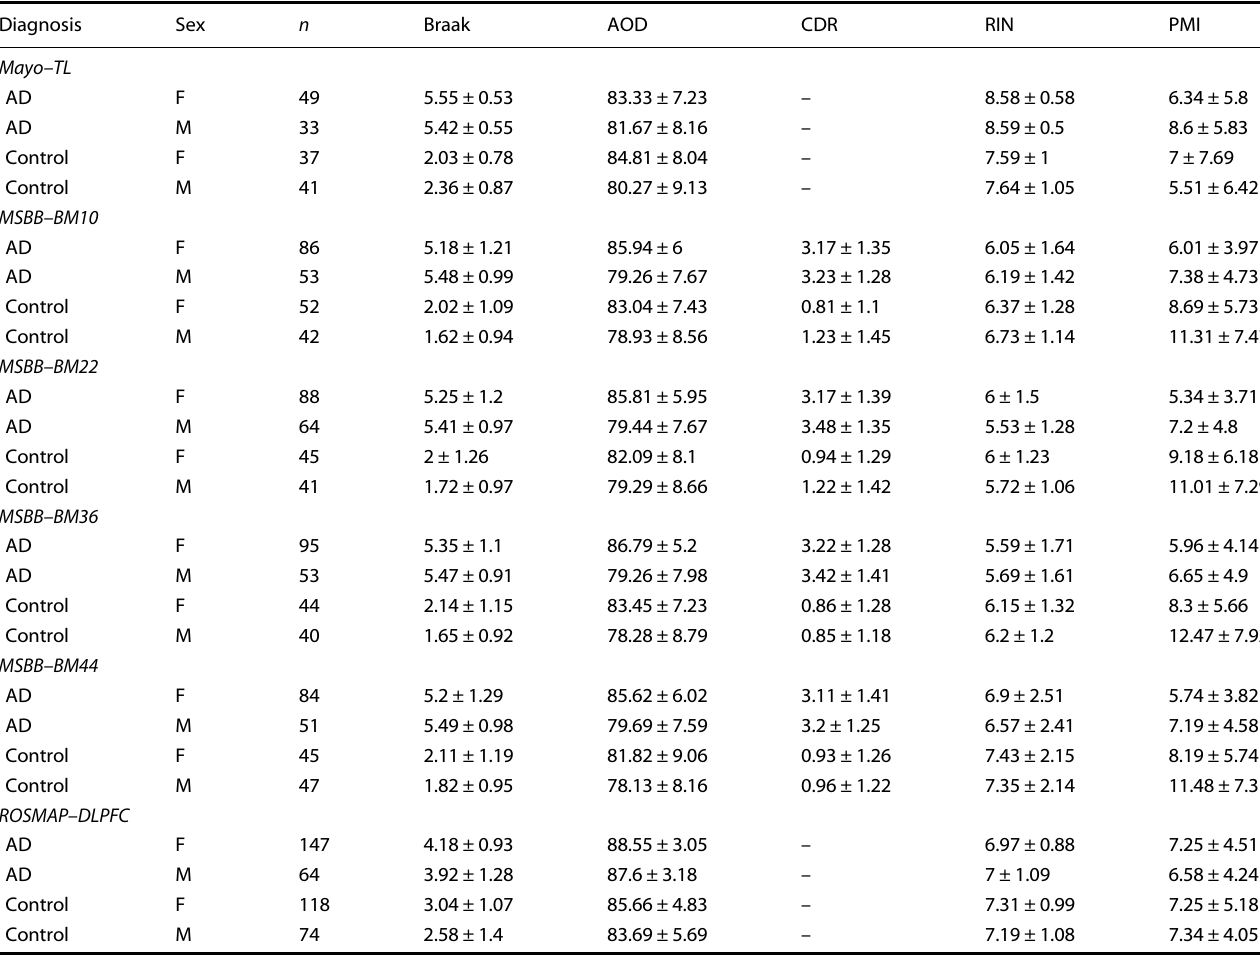
Table 1. Summary of clinical, demographic, and technical variables of samples analyzed from different datasets.